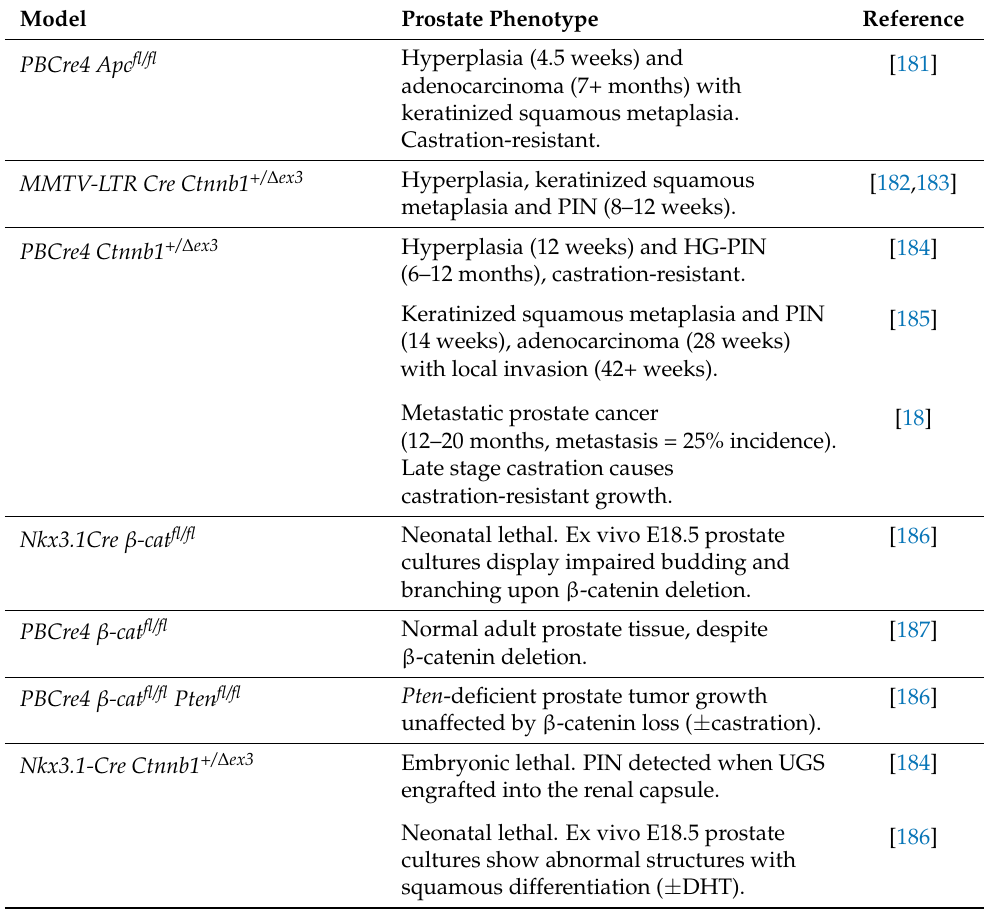
Table 2. Summary of GEMMs generated to explore Wnt signaling in prostate